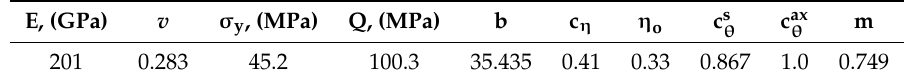
Table 1. Material properties and parameters used in the plasticity model in Equations (3) and (4).